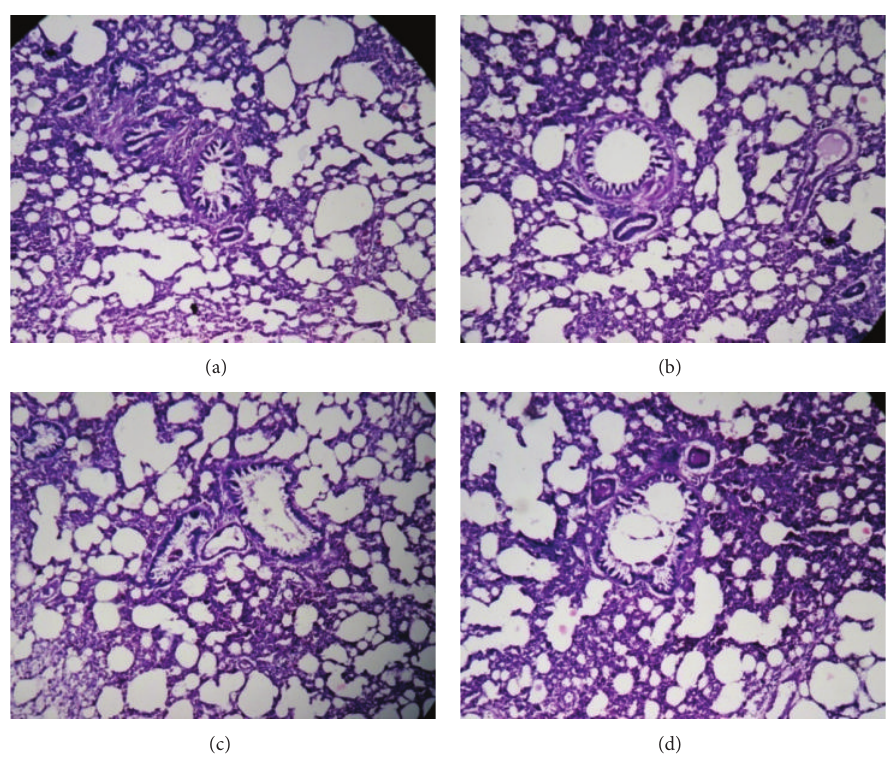
Figure 4: Histology of spleen (H&E, 100x) of control and OSE-treated animals. (a) Section of spleen from control animal showed normal granular hemosiderin pigment predominantly within macrophages in the red pulp; ((b), (c), and (d)) spleen from OSE (200, 400, and 800 mg/kg)-treated animals exhibit normal hemosiderin pigment predominantly within macrophages in the red pulp with normal